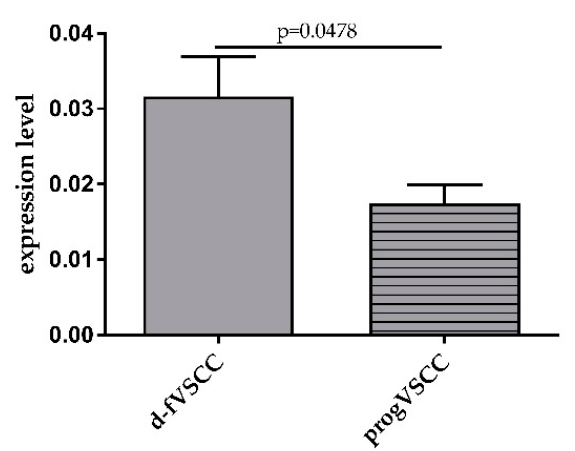
Figure 2. Comparison of normalized miR-431-5p expression levels in plasma obtained from patients with primary VSCC who progressed (progVSCC) and from those who were disease-free (d-fVSCC) during follow-up.